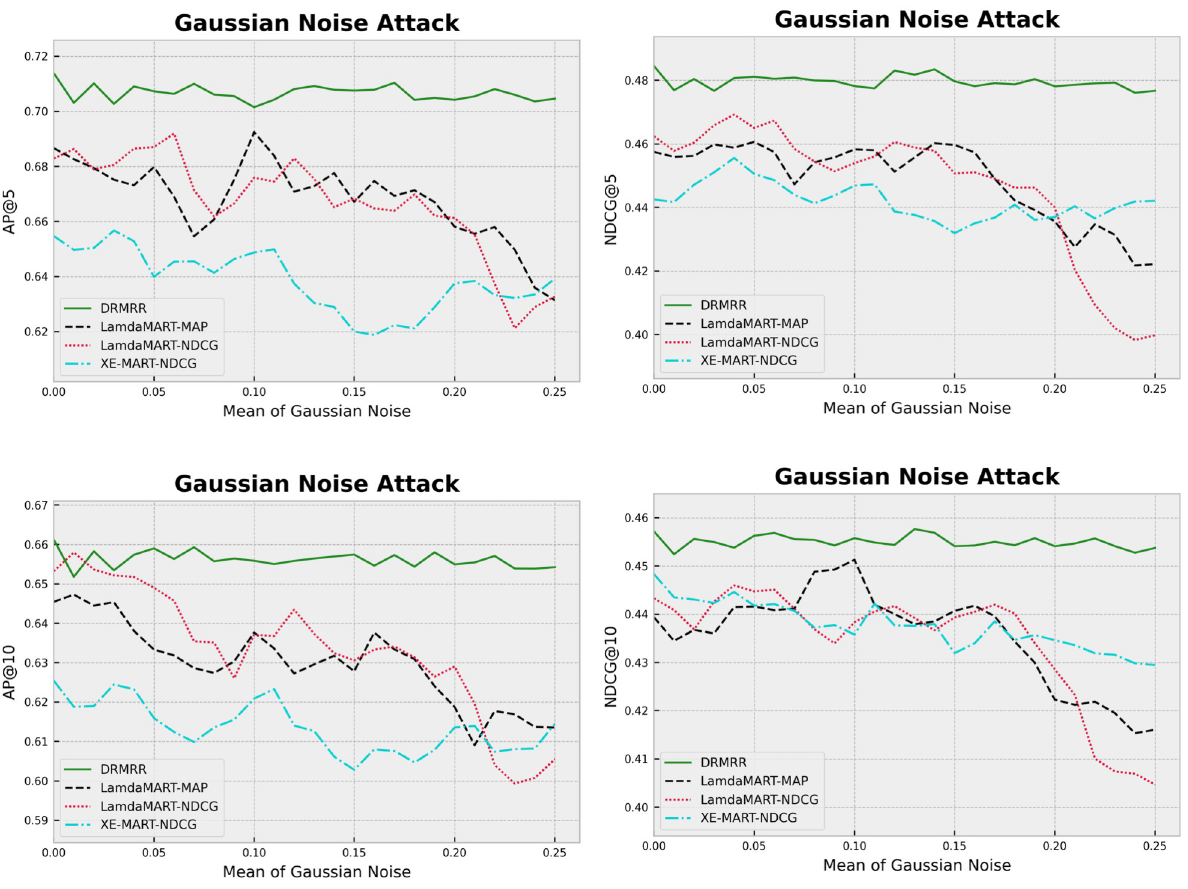
Fig 2. The impact of Gaussian noise on the performance of ranking